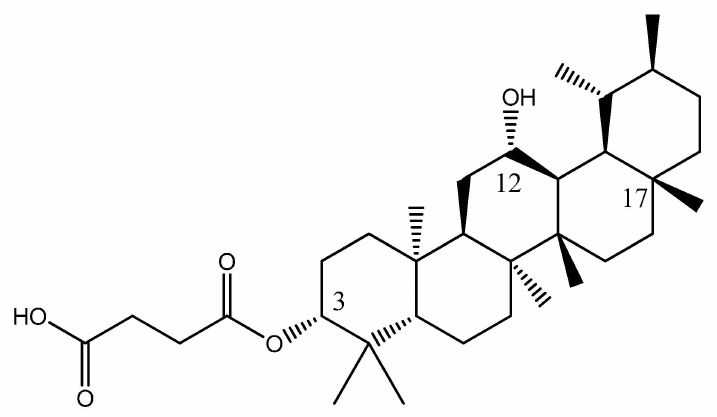
Figure 4. Structure of new PTC A